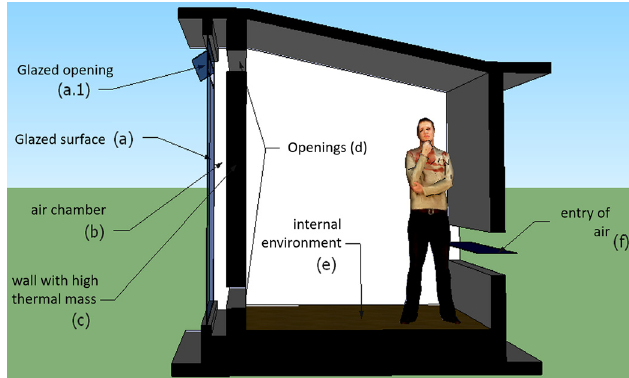
Fig. 1. Con fi guration of a